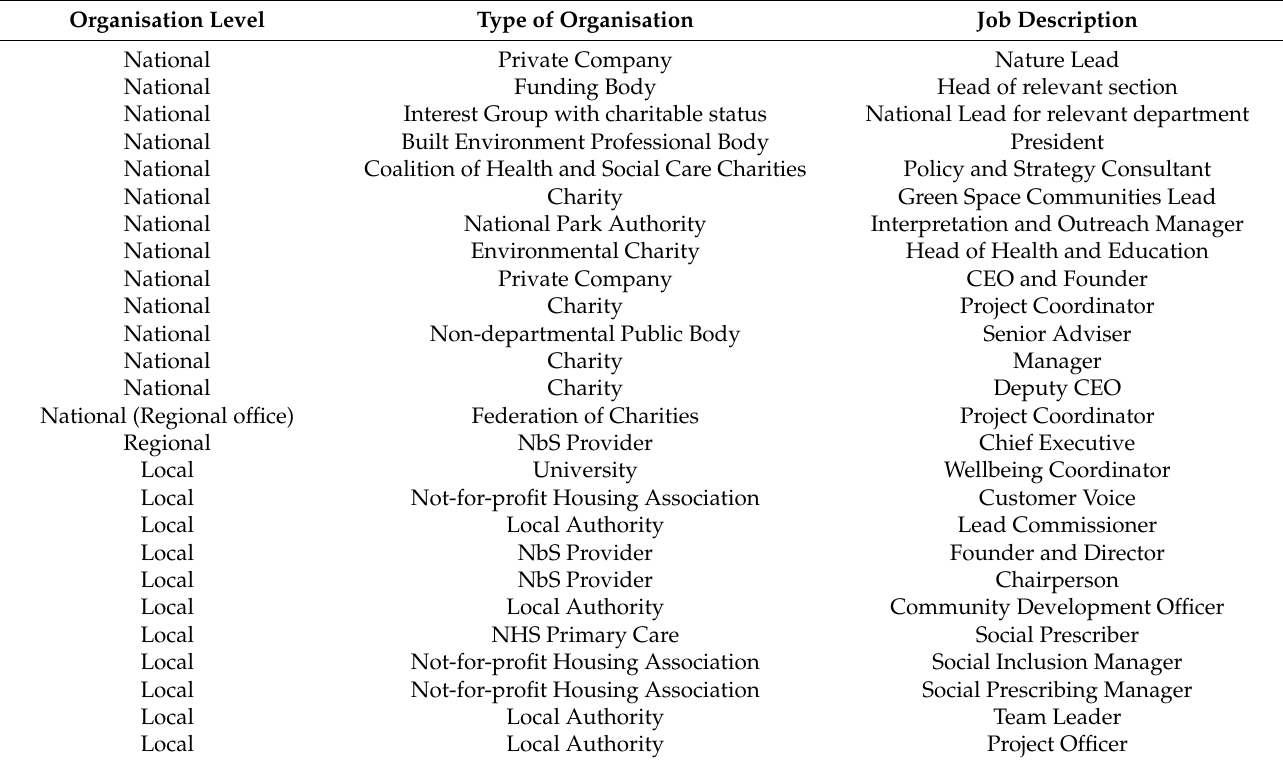
Table 1. Participants’ roles and